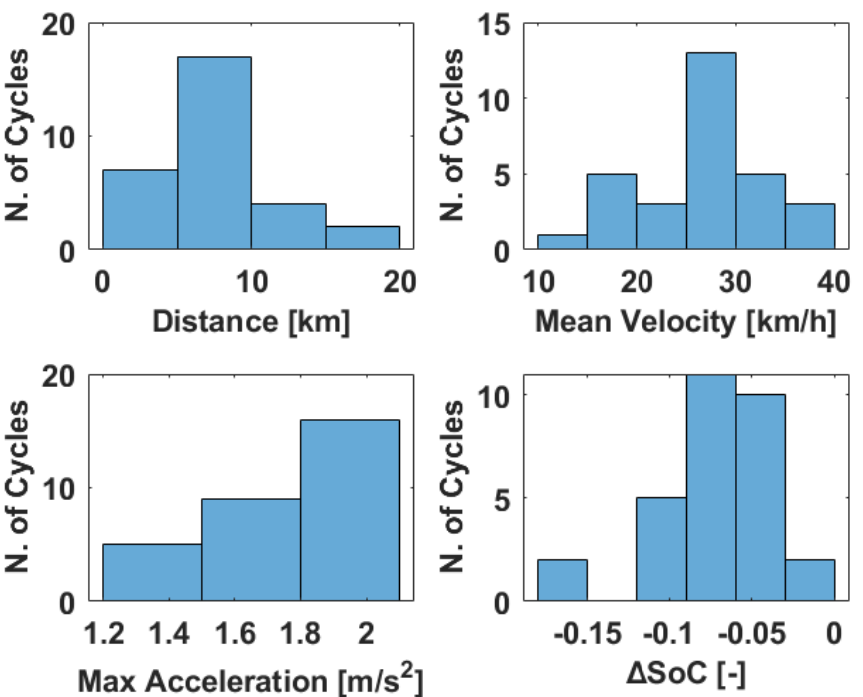
Figure 13. Distribution of the travelled distance, mean velocity, maximum acceleration and battery state of charge variations for any driving mission in the entire experimental dataset.